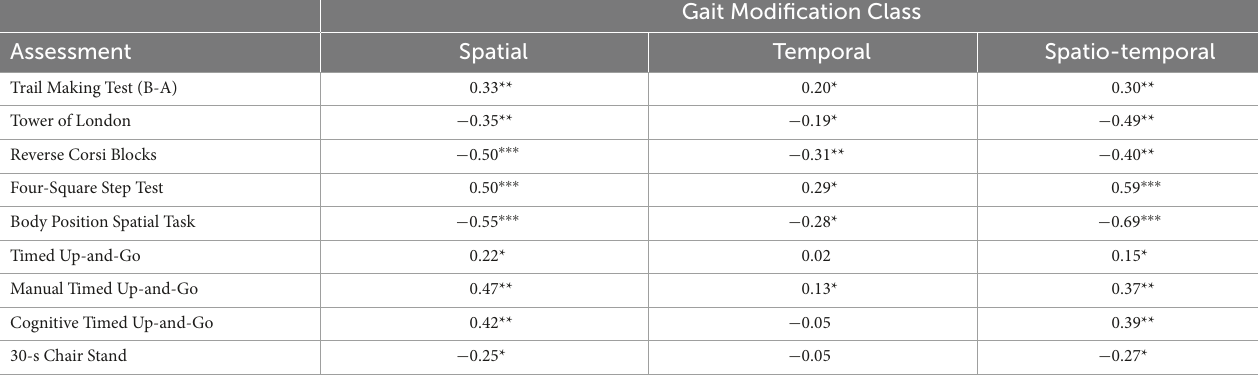
TABLE 3 Correlations (Pearson’s r) between RMS performance in each of three gait modification classes clinical